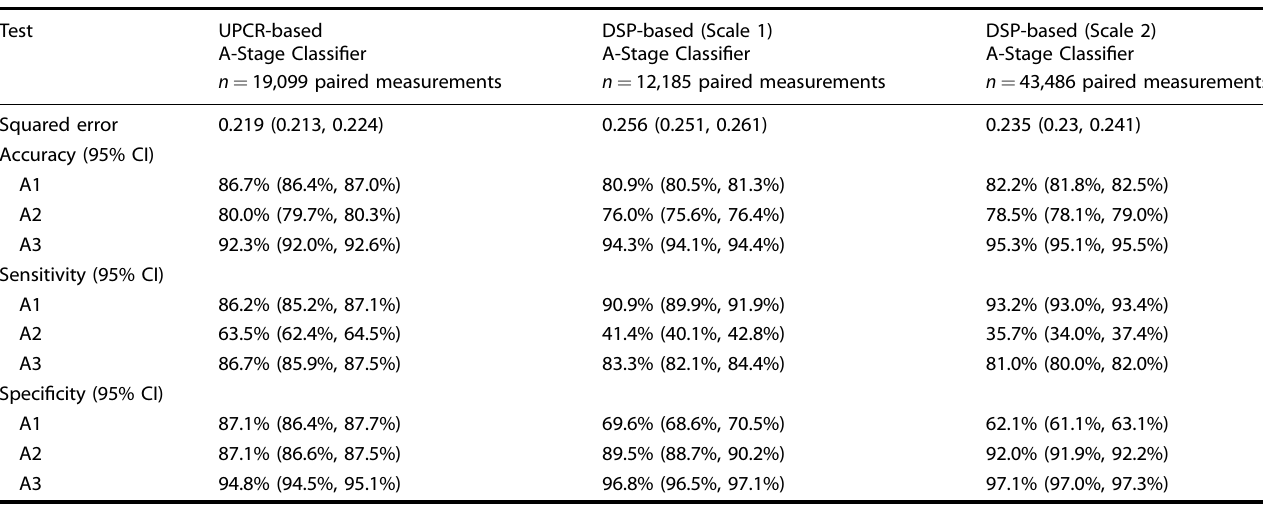
Fig. 1 Electronic CKD diagnosis and staging algorithm. a Flowchart of the National Kidney Foundation (NKF) criteria-based algorithm composed of three parts: data pre- fi ltering, G-staging, and A-staging b G-Stage Classi fi er for staging of CKD based on estimated glomerular fi ltration rate (eGFR), and c A-Stage Classi fi ers for staging of CKD based on albuminuria. UACR Urine Albumin-to-Creatinine Ratio, UPCR Urine Protein-to-Creatinine Ratio, A24 24-h urine collection for albumin, P24 24-h urine collection for protein, UA Urinalysis, SG Speci fi c Table 1. Overall performance of the A-stage classi fi ers used in the algorithm.